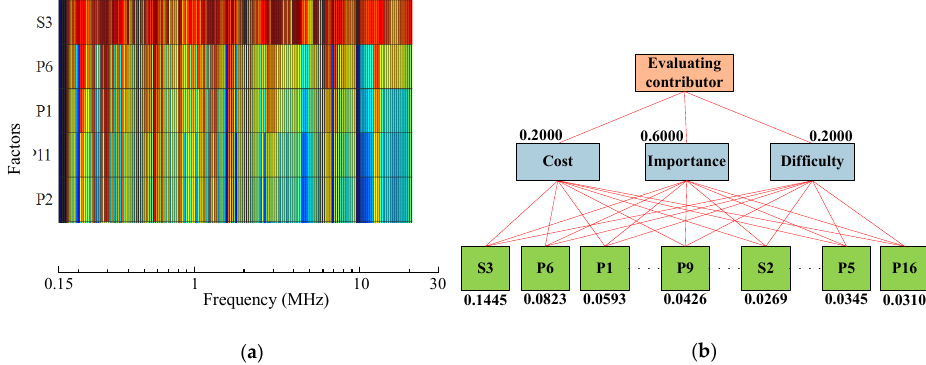
Figure 12. Problem analysis results: ( a ) Importance analysis results; ( b ) Hierarchical analysis for final solution.